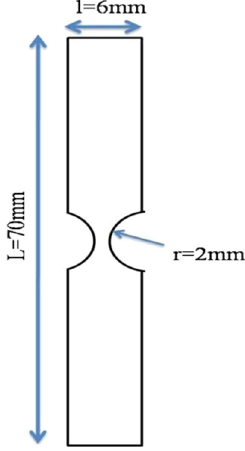
Fig. 1. 2D diagram of the specimen.